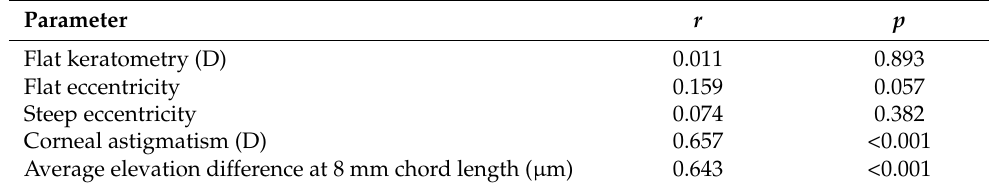
Figure 3. Boxplots showing that a higher lens toricity corresponded to ( a ) a higher corneal astigmatism and ( b ) a higher average elevation difference at 8 mm chord length. Table 2. Correlation of lens toricity with baseline ocular biometrics using Spearman’s correlation analysis.